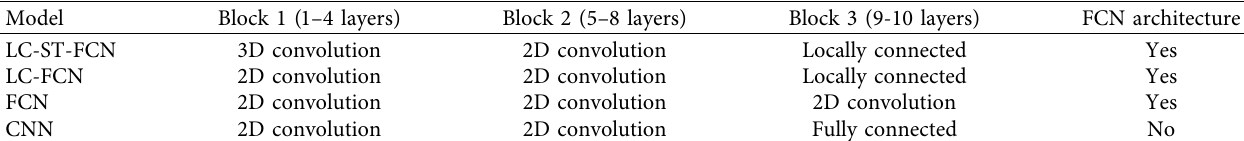
Table 2: Comparison of model